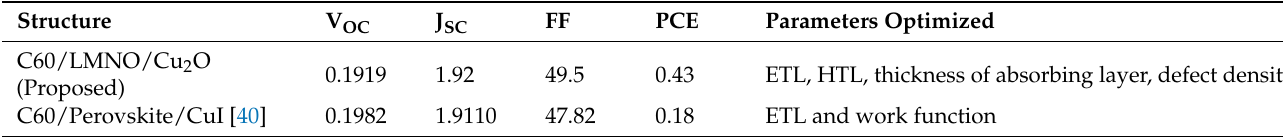
Table 4. Effect on efficiency and Voc with defect density.